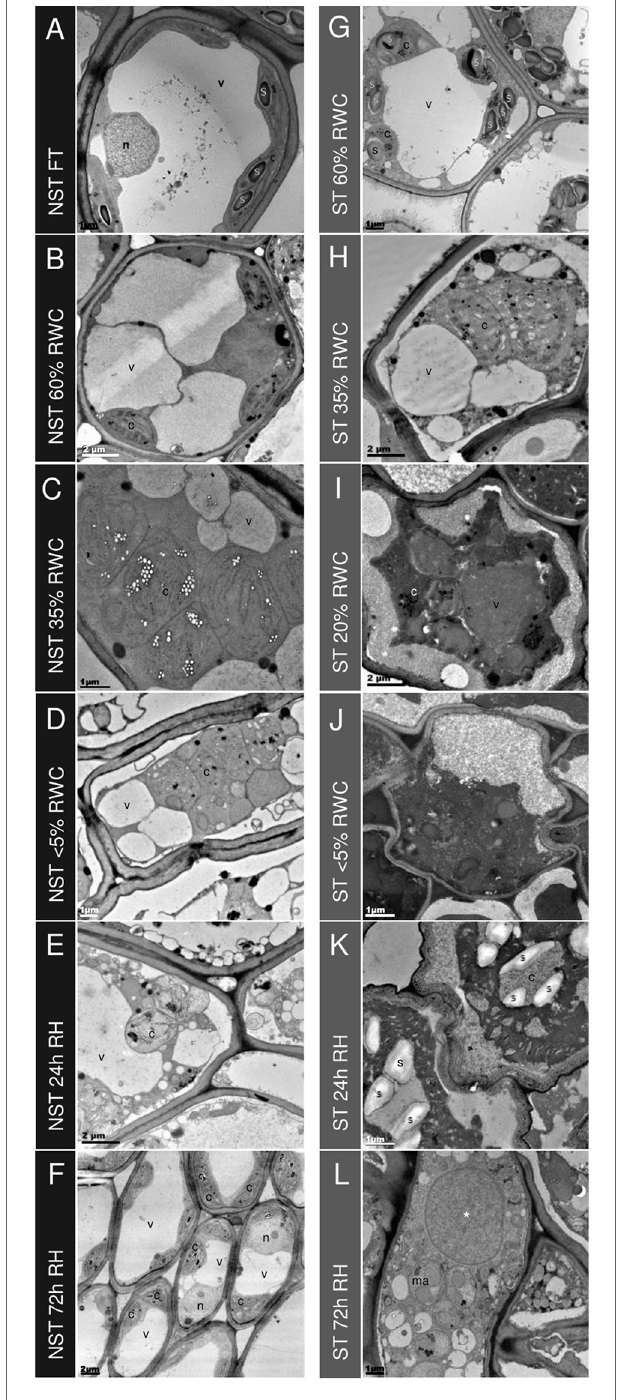
FigURe 4 | Ultrastructural changes during desiccation and rehydration. Transmission electron micrographs of mesophyll cells in non-senescent tissues (NST) (left column A-F) and ST (right column G-L) from the same leaves during desiccation and rehydration, with relative water content (RWC) for each on the left. When NST mesophyll cells are at FT (A) , a central electron opaque vacuole is surrounded by active (indicated by the presence of starch) chloroplasts with good thylakoid organization. As plants experience water deficit, the central vacuole splits into several smaller vacuoles (B – D) and the chloroplasts become swollen and lose thylakoid membrane organization. Once rehydrated (e – F) , NST mesophyll quickly regains the structure observed in the hydrated state, with reformation of the central vacuole observed at 24 h (e) and thylakoid organization regained by 72 h (F) . The presence of starch granules in peripheral chloroplasts indicates regaining of photosynthetic competence (F) . Mesophyll cells of the ST (g – L) experience lower corresponding water contents during water deficit and this is evident on the ultrastructural level with mesophyll cells from fully hydrated plants (60% RWC in ST) resembling the organization of drying NST (G compared to B). Drying below 35% in ST results in a different appearance of mesophyll in ST from that of NST—the cytoplasm becomes increasingly electron dense (i – L) and there appears to be contraction of the membrane from the cell wall (i – J) , and cell wall folding (J – K) . Of the cells that are not lysed in rehydrated mesophyll (L) , there is evidence of macroautophagy and the appearance of a large electron dense vesicle (*). Symbols are used to indicate organelles: vacuoles (v), nuclei (n), chloroplasts (c), starch granules (s), electron dense vesicle (*), and macroautophagosomes